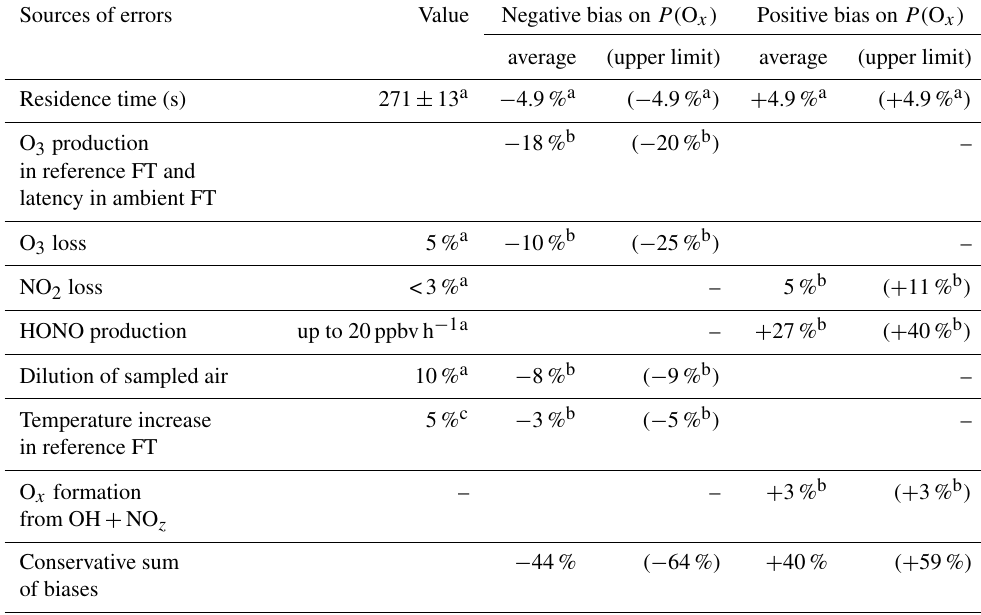
Table 1. Sources of errors on P (O x ) measurement. Upper limits and campaign averages of errors assessed from modeling the selected days of the MCMA 2006 and CalNex 2010 field campaigns (see text). FT: flow